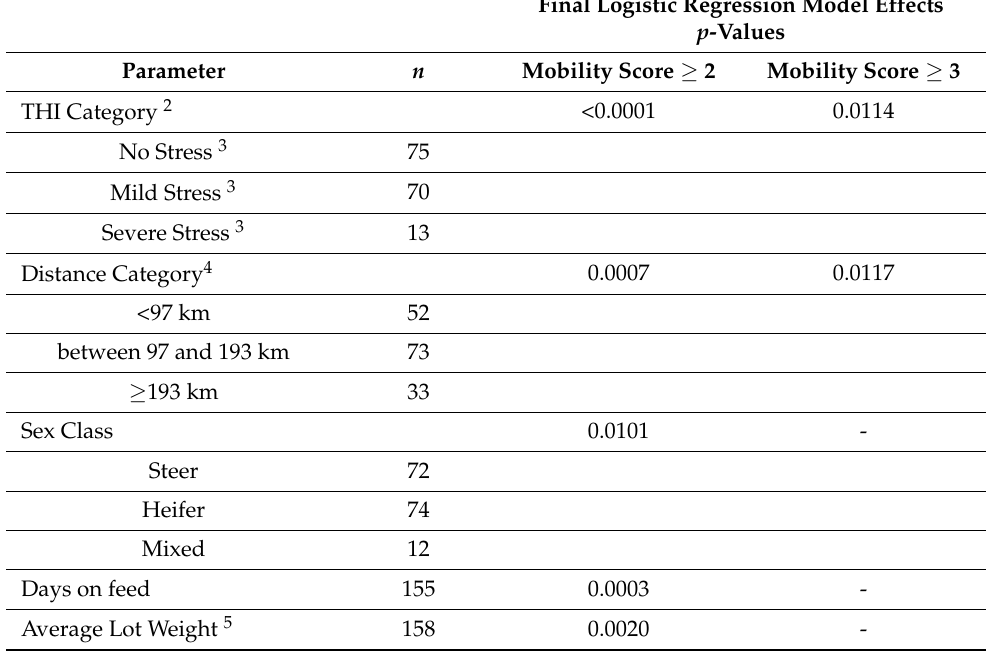
Table 5. Final logistic regression models of the lot ( n = 158) level risk factors associated with mobility scores 1 ≥ 2. and ≥ 3 in fed